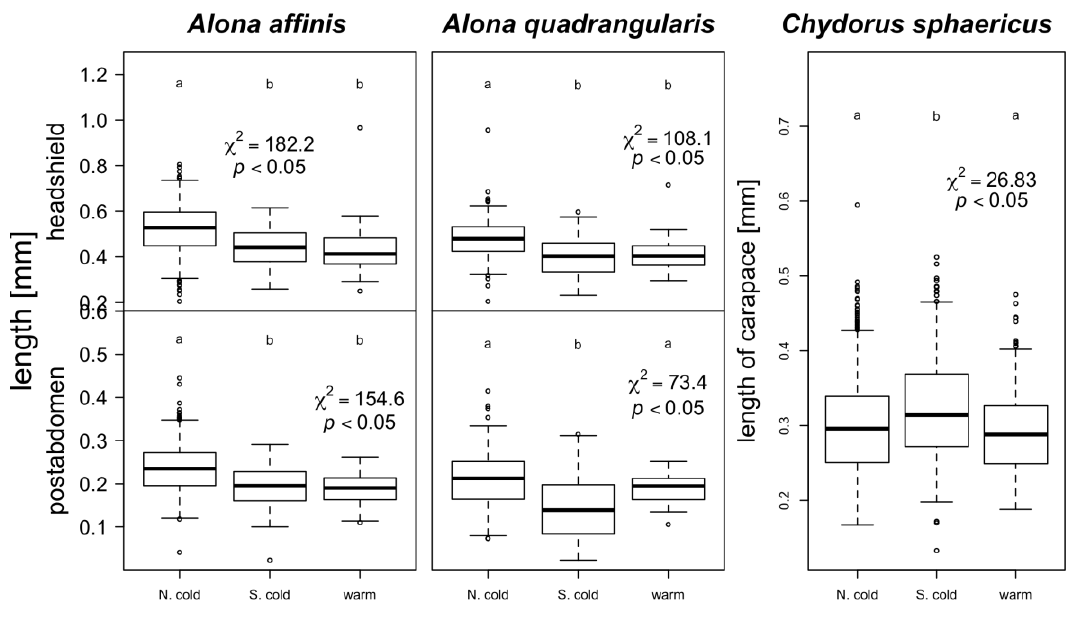
Figure A3. Regional differences in length of headshields, postabdomen and carapaces ( Alona affinis , A. quadrangularis and Chydorus sphaericus , N.cold: Nordic cold lakes, S.cold: high mountain lakes, warm: lakes in the south of Europe; groups with the same letters are not distinguishable, whereas groups with different letters differ significantly).